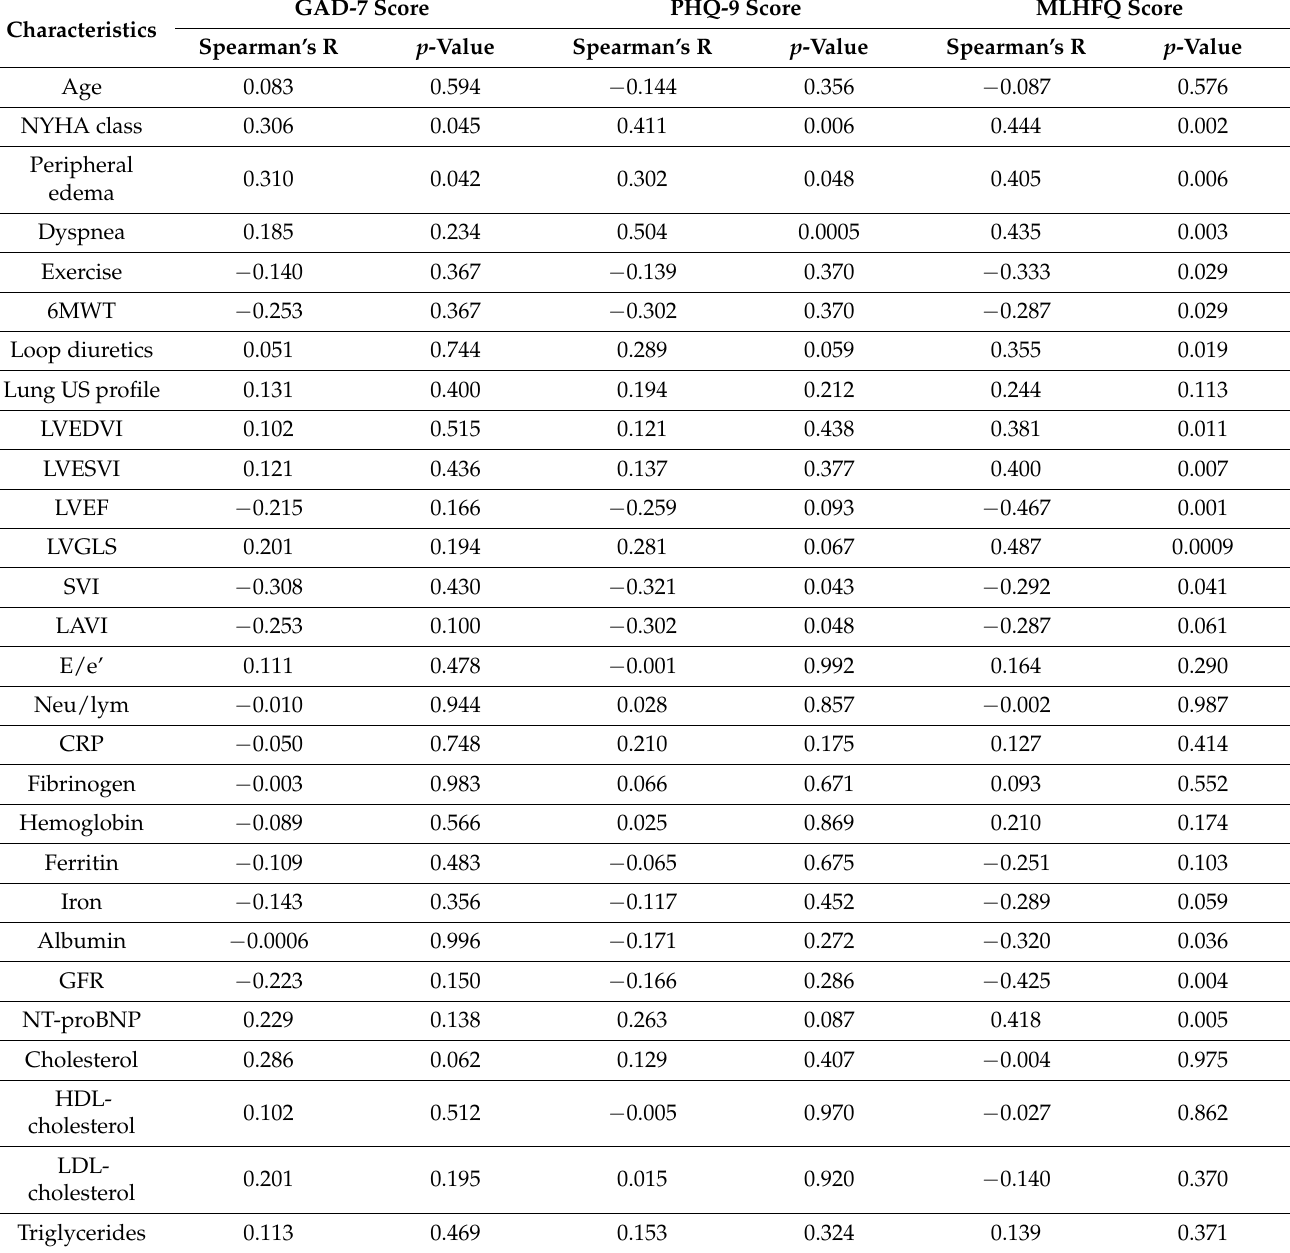
Table 3. Correlations for GAD-7, PHQ-9, and MLHFQ scores in the overall group (n =